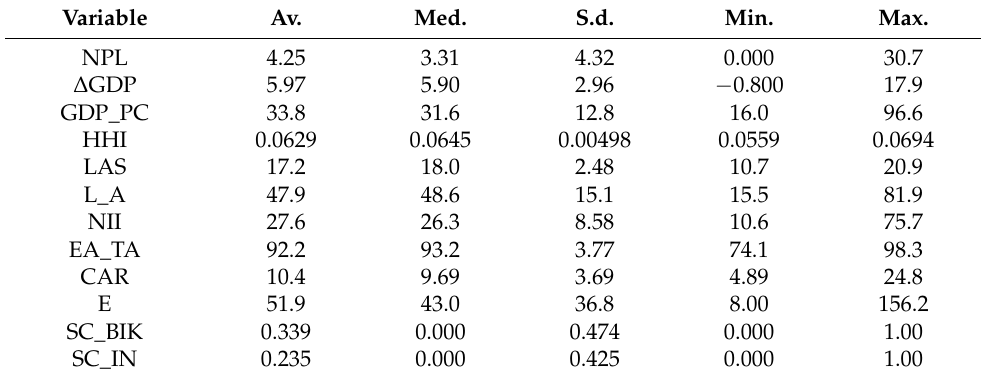
Table 3. Descriptive statistics of the variables used in the model.